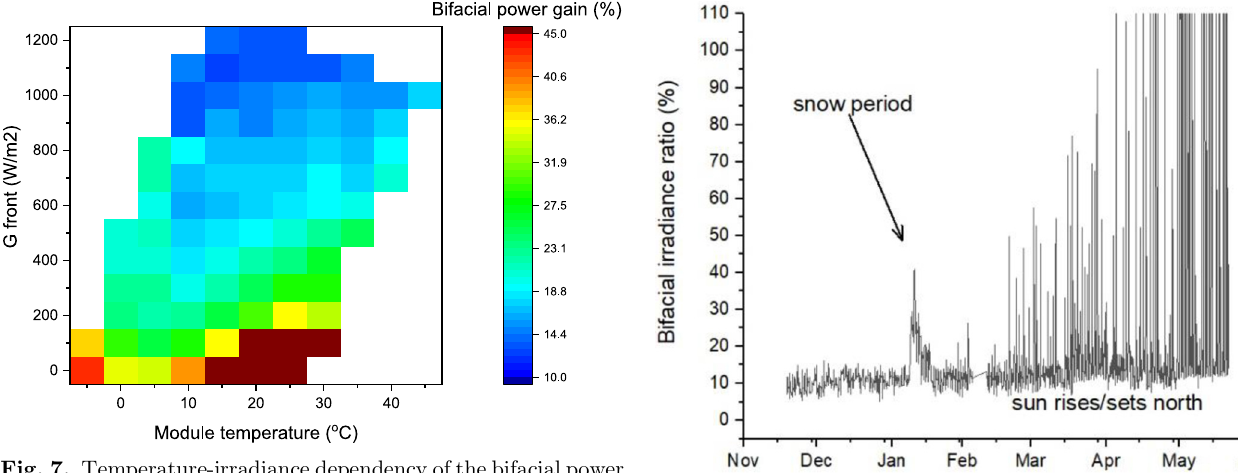
Fig. 7. Temperature-irradiance dependency of the bifacial power gain. For higher irradiances, bifacial power gain is less. For higher temperatures,thebifacialityislessaswell.Thelowerbifacialpower gain for higher irradiances is caused in the midrange by weather conditions,andinthelowerrangebythechangingsolarangles.The lower gain for higher temperatures is caused by the higher temperature dependency of the bifacial rear device as compared to the front device. The gain of high temperature low irradiance is very high as that is caused by northern sunset/sunrise.